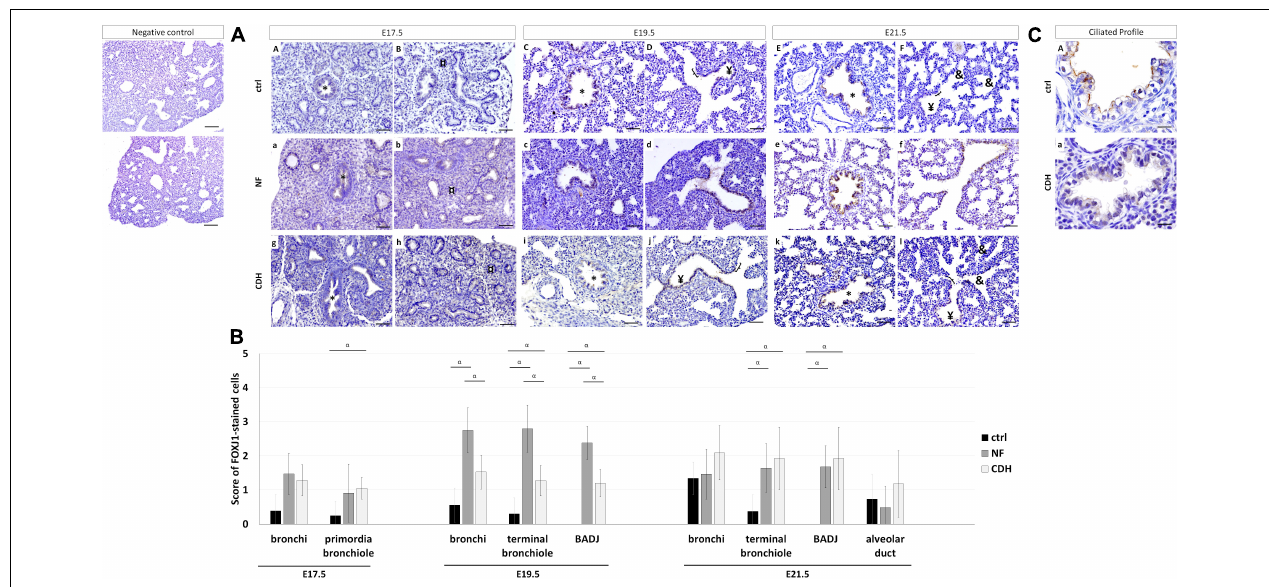
FIGURE 3 | Spatiotemporal distribution of forkhead box J1 (FOXJ1) in normal and induced-congenital diaphragmatic hernia (CDH) rat model at pseudoglandular, canalicular, and saccular stages. Representative immunohistochemical evidence for FOXJ1 expression at (AA,B,a,b,g,h) embryonic day (E)17.5, (AC,D,c,d,i,j) E19.5, and (AE,F,e,f,k,l) E21.5 in normal (ctrl), nitrofen (NF), and CDH lungs, respectively. *Bronchiole; ¤ primordia of bronchiole; (cid:85) terminal bronchiole; [bronchioalveolar duct junction; & alveolar duct. Scale bar 50 µ M. (B) Semi-quantitative analysis of FOXJ1 expression from pseudoglandular-to-saccular stages in ctrl, NF, and CDH lungs. Results are presented as mean ± SD. Symbols indicate the main effects and non-redundant interactions of T -test for independent samples. α p < 0.05. (C) Representative immunohistochemical evidence for the absence of multi-cilia on the plasma membrane of ciliated cells in bronchi at E21.5. Original magnification × 600.